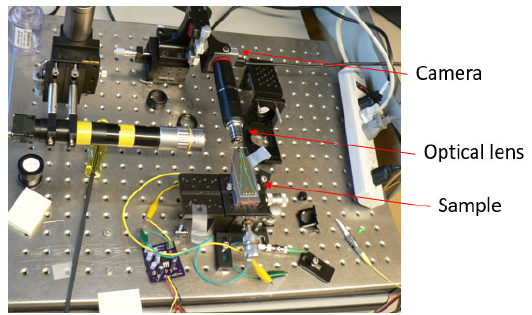
Figure 4. Experimental setup used to image the vibrating tip.